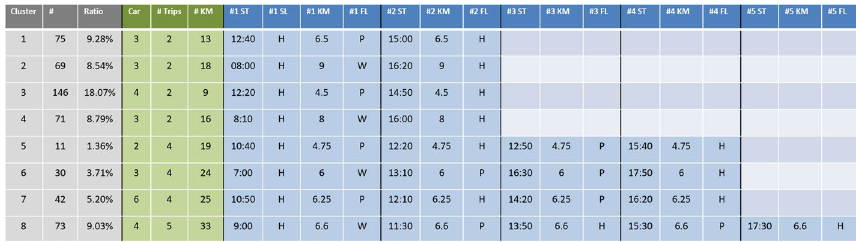
Fig. 7 First eight clusters of the EV behavior